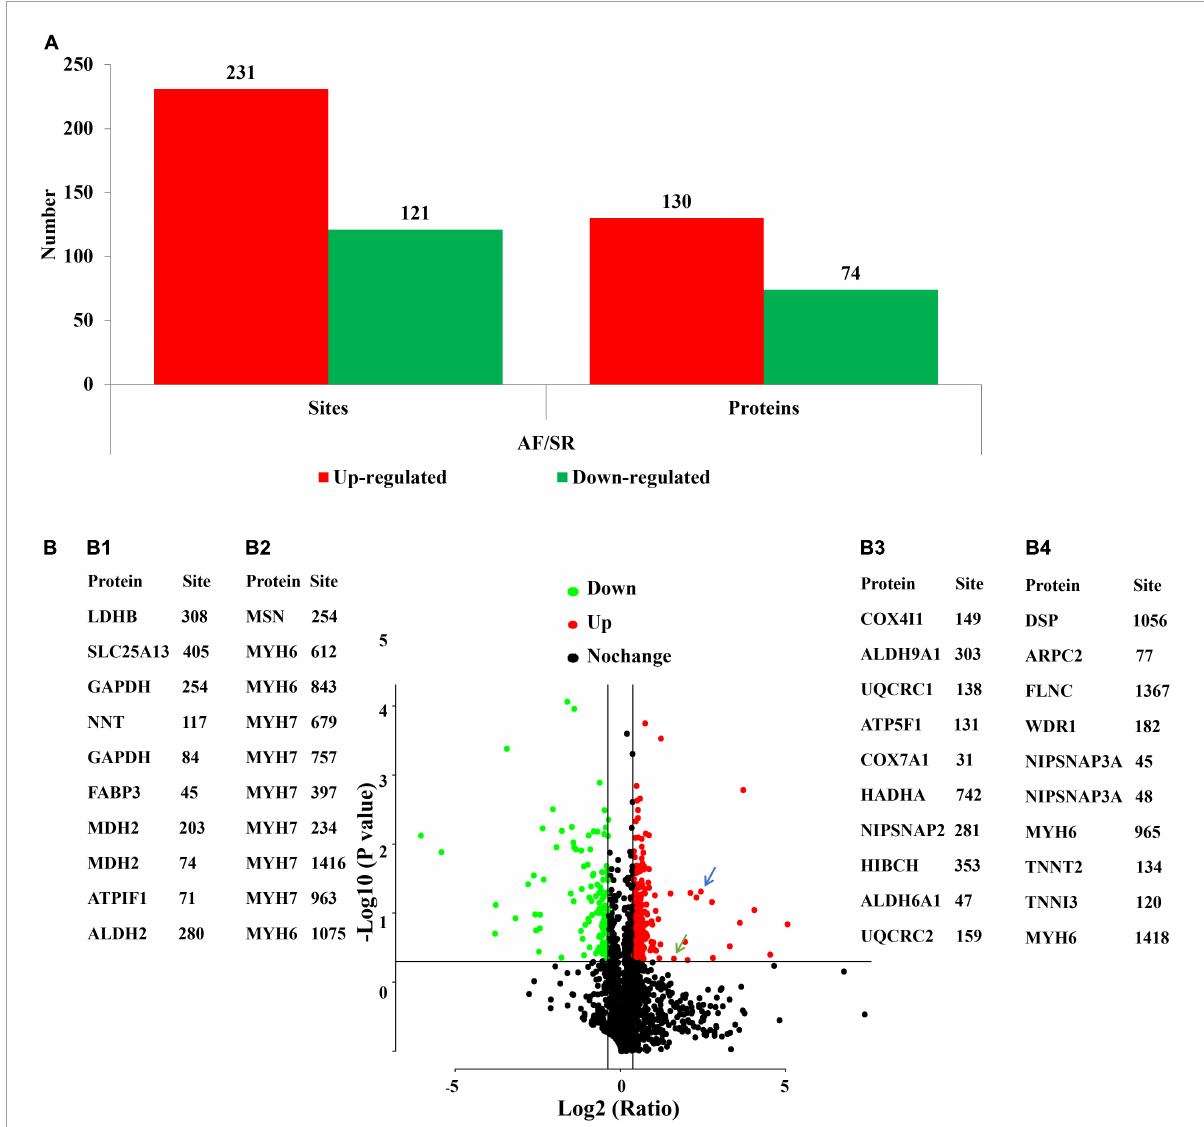
FIGURE2 AF/SR differentially expressed analysis of acetylated proteome in LAA tissues. (A) Bar graph showing the number of upregulated (AF/SR ratio > 1.3) and downregulated (AF/SR ratio < 1/1.3) Kac sites and Kac proteins. (B) Volcano plots of the p- values vs. the log differences between LAA tissues from the AF and SR group patients, with Kac proteins outside the significance line colored in red (upregulated) or green (downregulated) (false discovery rate < 0.05). (B1,B2) show the top 10 downregulated Kac sites on Kac proteins related to energy metabolism and cellular contraction, respectively; (B3,B4) show the top 10 upregulated Kac sites on Kac protein related to energy metabolism and cellular contraction, respectively. The blue arrow represents cytochrome c oxidase subunit 5A, mitochondrial (COX5A) in energy metabolism-related proteins, and the green arrow represents vinculin (VCL) in cellular contraction-related proteins. P -values were calculated from the data of the acetylated proteome in LAA tissues from the AF and SR group patients. AF, atrial fibrillation; SR, sinus rhythm; LAA, left atrial appendage.